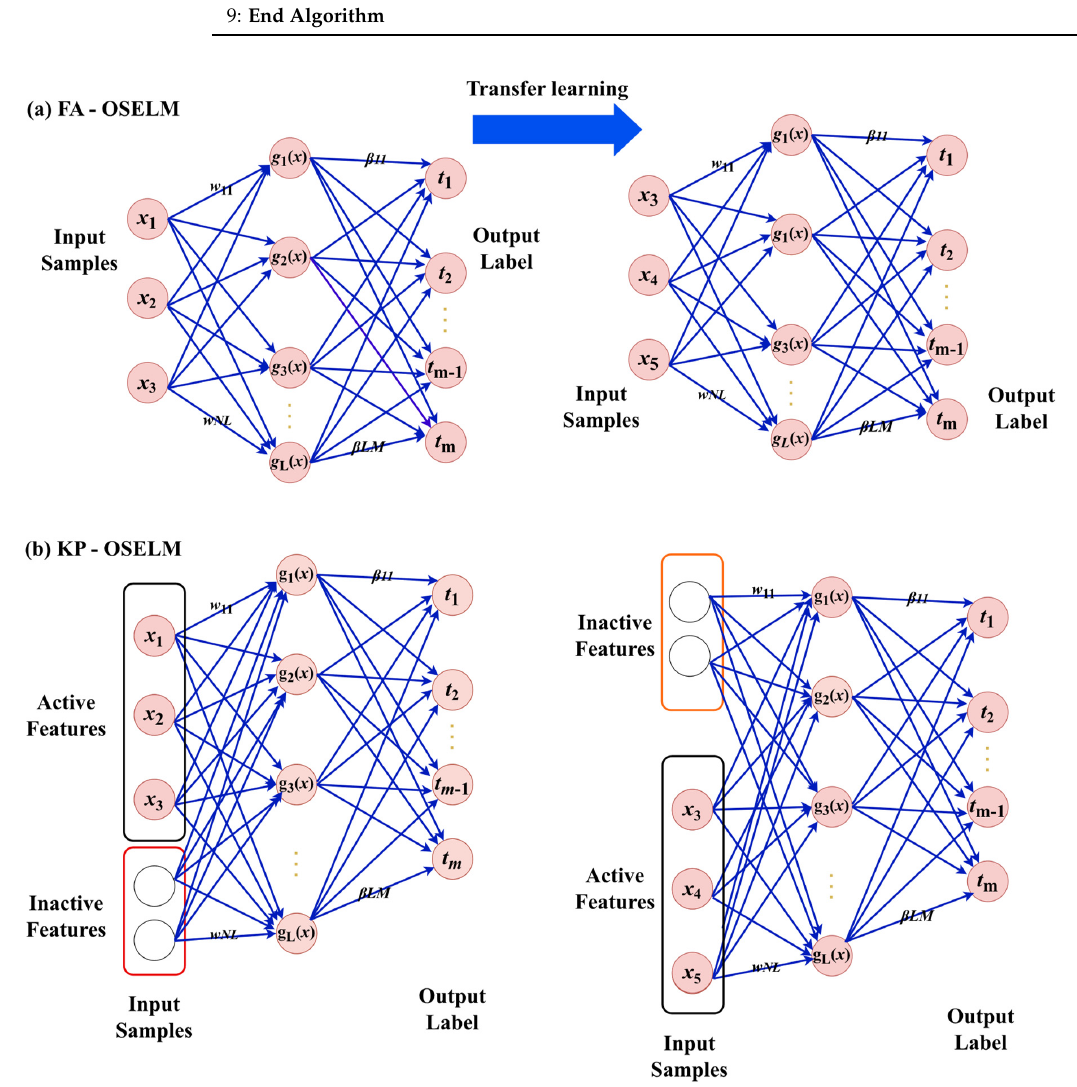
Figure 2. The evolution of a Single Layer Feed-forward Network (SLFN) with respect to the changes in the number of features. The structure of two variants of Online Sequential Extreme Learning Machine (OSELM) algorithms, namely, Feature Adaptive OSELM (FA-OSELM) and Knowledge Preserving OSELM (KP-OSELM), are shown in ( a ) and ( b ), respectively .